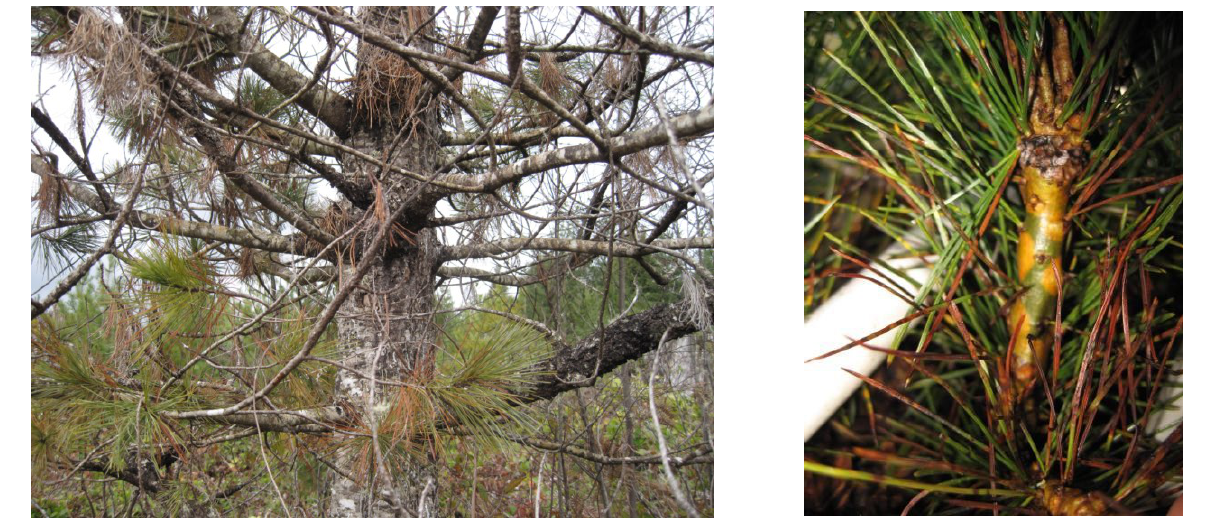
Figure 3. Large, dying western white pine with hundreds of blister rust cankers on branches and main stem ( left ), and whitebark pine seedling with many stem infections, 13 months after artificial inoculation with C. ribicola ( right